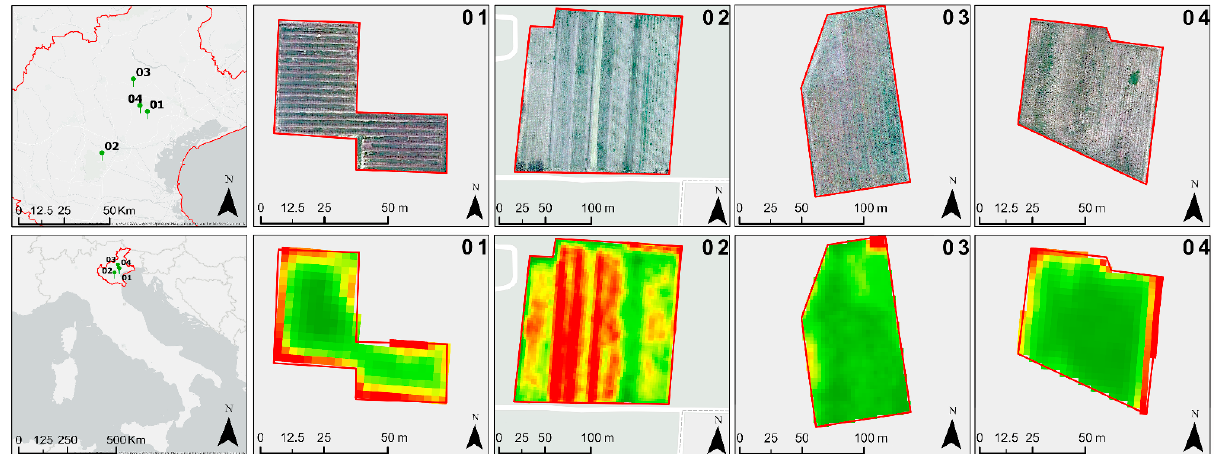
Figure 2. Location of M. alba experimental fields considered in the present work and their representation: top, high resolution from Google Earth (visible), bottom, high resolution from PlanetScope (NDVI).